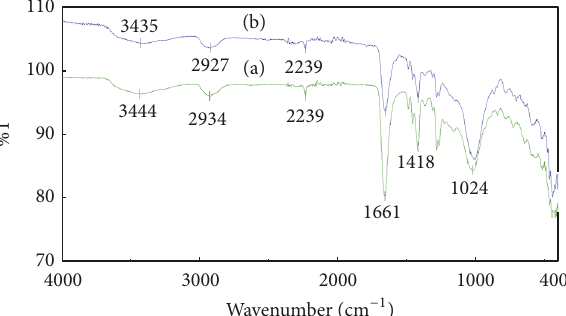
Figure 1: IR spectrum of the poly(AN-co-VP)/zeolite composite (a) before adsorption and (b) after